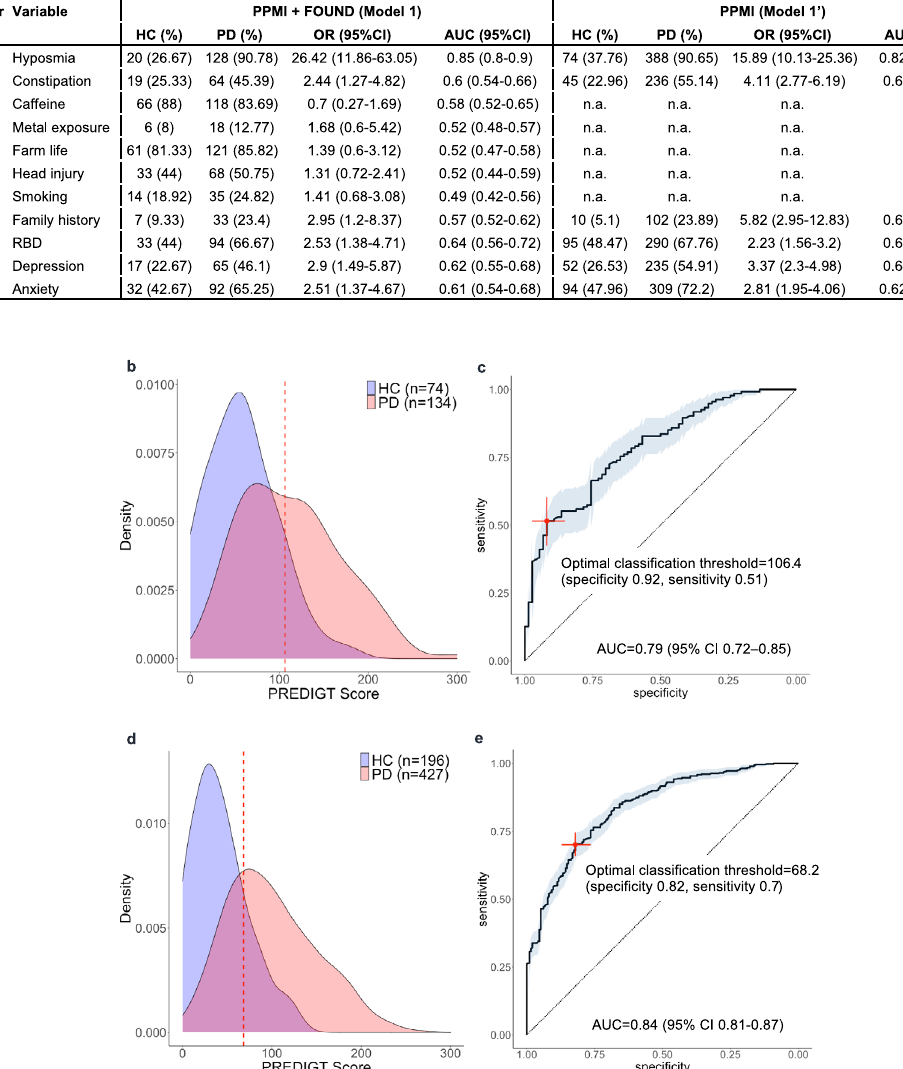
Fig. 2 Evaluation of the original PREDIGT Score in the PPMI + FOUND cohort (Model 1; Model 1 ’ ). a Table of variables and their associated effect sizes, as gleaned from the OR [95% CI], the AUC values from corresponding univariate logistic regression analyses, and the number of subjects (with percentage, %) for positive cases in each group. Variables within each factor were listed in decreasing order of their AUC values; b , d score density plots of Model 1 and Model 1 ’ , respectively; c , e ROC curves of Model 1 and Model 1 ’ , respectively. The red, dashed lines in panels b and d , and crosses in corresponding c and e indicate the optimal threshold (score, Model 1: 106.2, Model 1 ’ : 63.0) to distinguish the two groups by the maximum Youden Index. Light blue shading in the ROC curve indicates the bootstrap-estimated 95% CI. n.a. data not available, PPMI Parkinson ’ s Progression Marker Initiative, FOUND FOllow Up persons with Neurologic Disease, OR odds ratio, CI con fi dence interval, ROC receiver operating characteristic, AUC area under the ROC curve, RBD REM sleep behavior